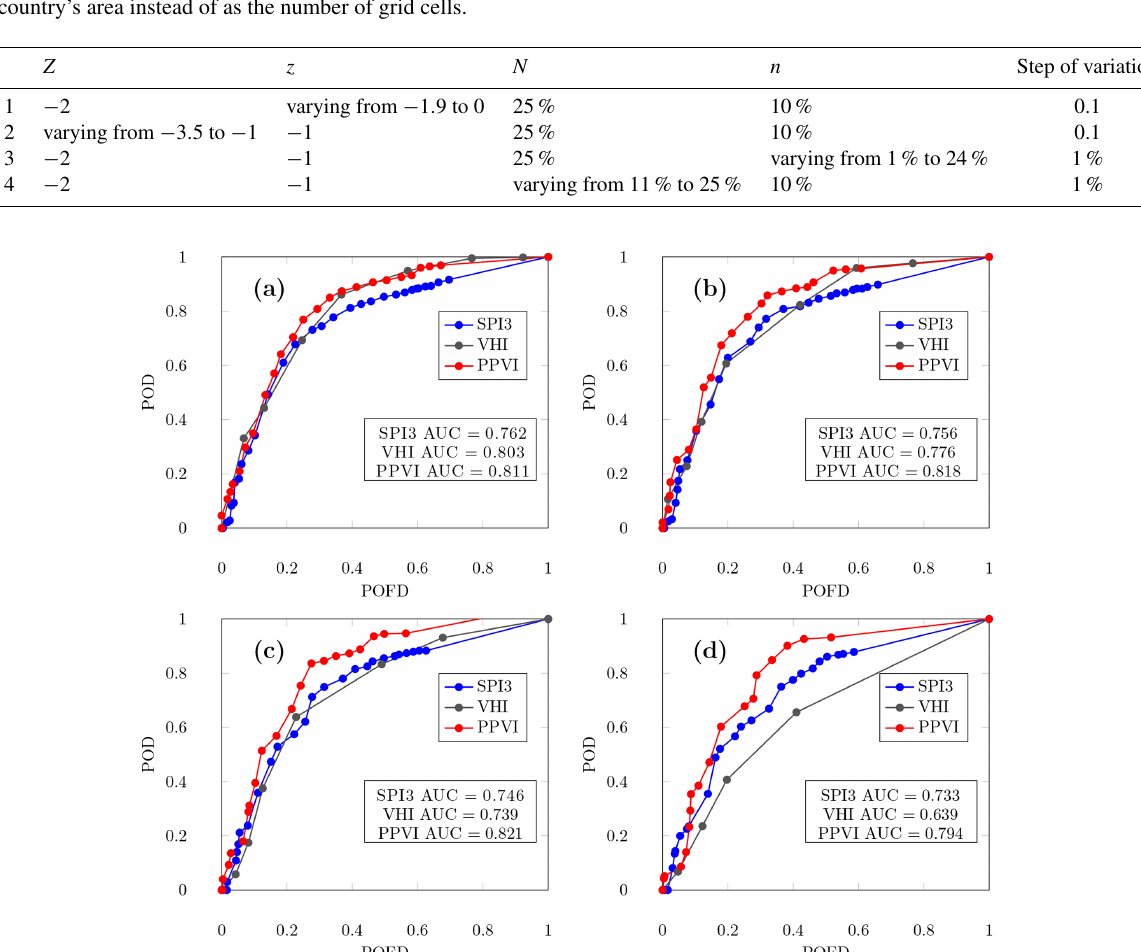
Figure 6. Comparison between the performances of the SPI3, VHI and PPVI in identifying reported drought events; thresholds Z , Z S and Z V are varying; z = − 1 . 1; z S = 0, and z V = 40; n = 80, and four cases for N are shown. (a) N = 10%; (b) N = 20%; (c) N = 30%; and (d) N =